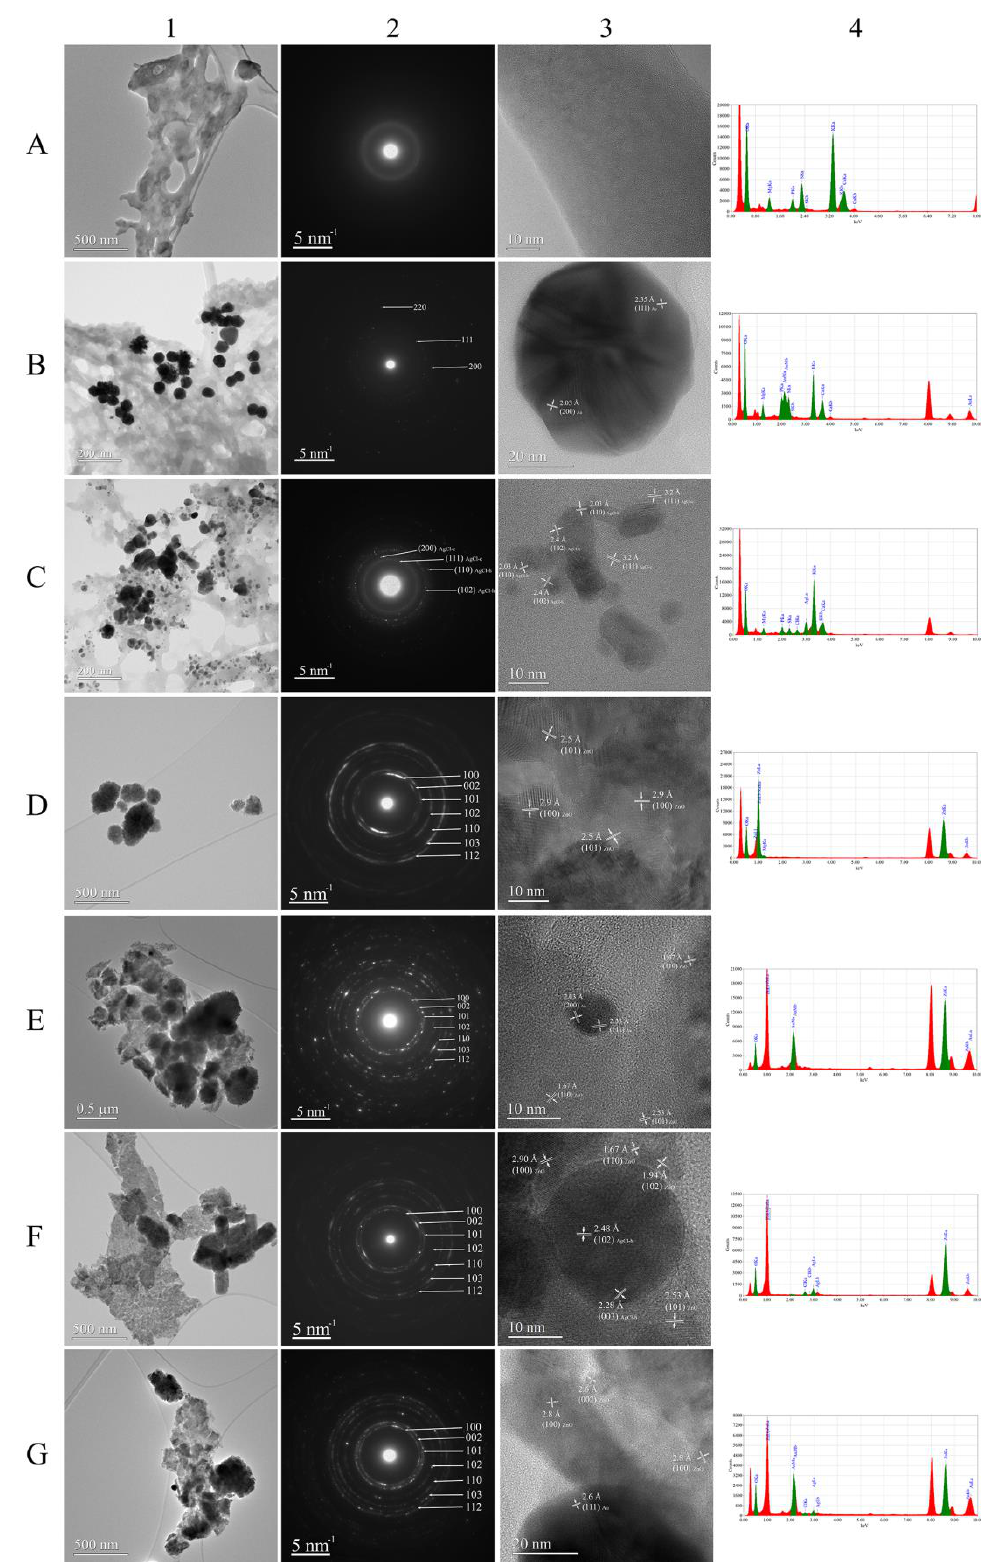
Figure 7. TEM results obtained using CTEM ( 1 ), SAED ( 2 ), HRTEM ( 3 ) and EDS ( 4 ) of samples for: burdock extract ( A ), AuNPs ( B ), AgClNPs ( C ), ZnO ( D ), AuZnO ( E ), AgClZnO ( F ) and AuAgClZnO ( G ).